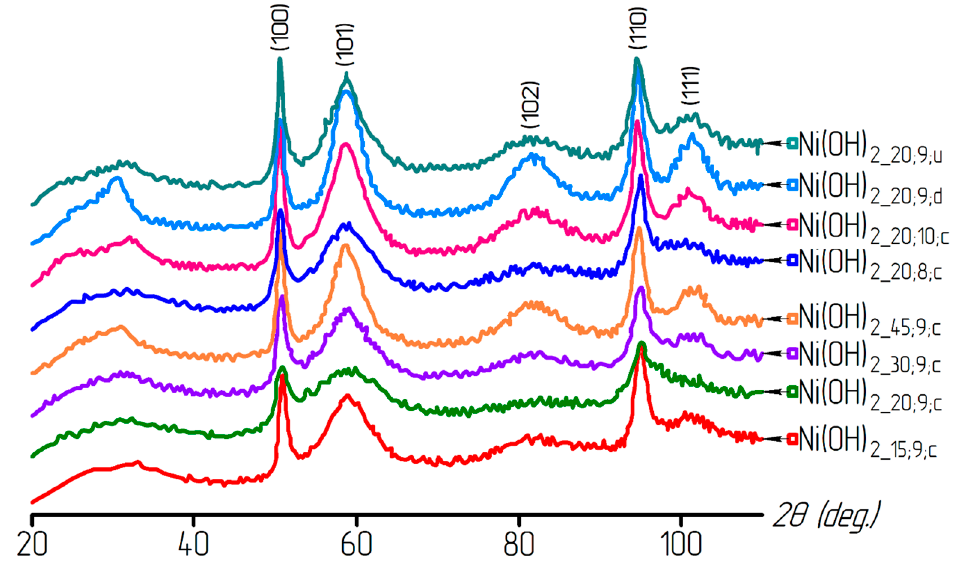
Figure 2. X-ray patterns of the nickel hydroxide samples obtained under various deposition conditions.